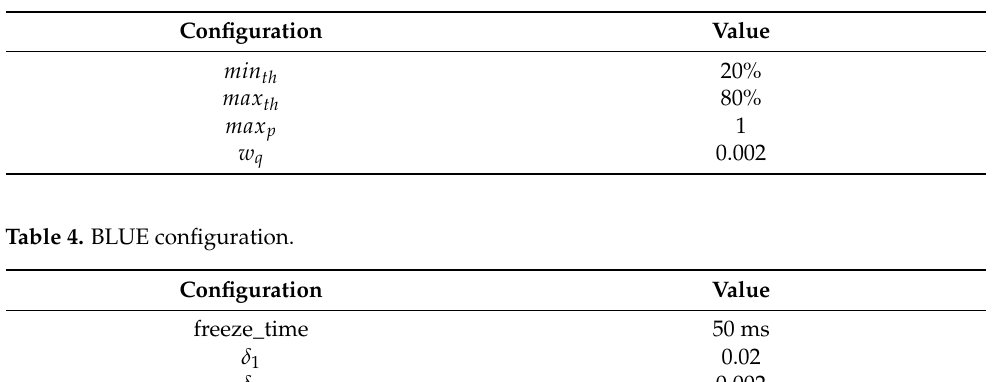
Table 3. RED configuration.